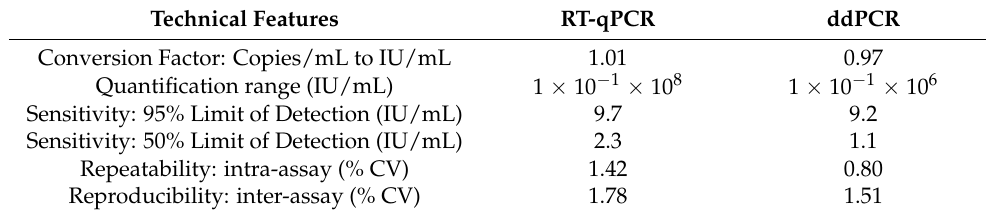
Table 4. Comparison of technical features between RT-qPCR and ddPCR.